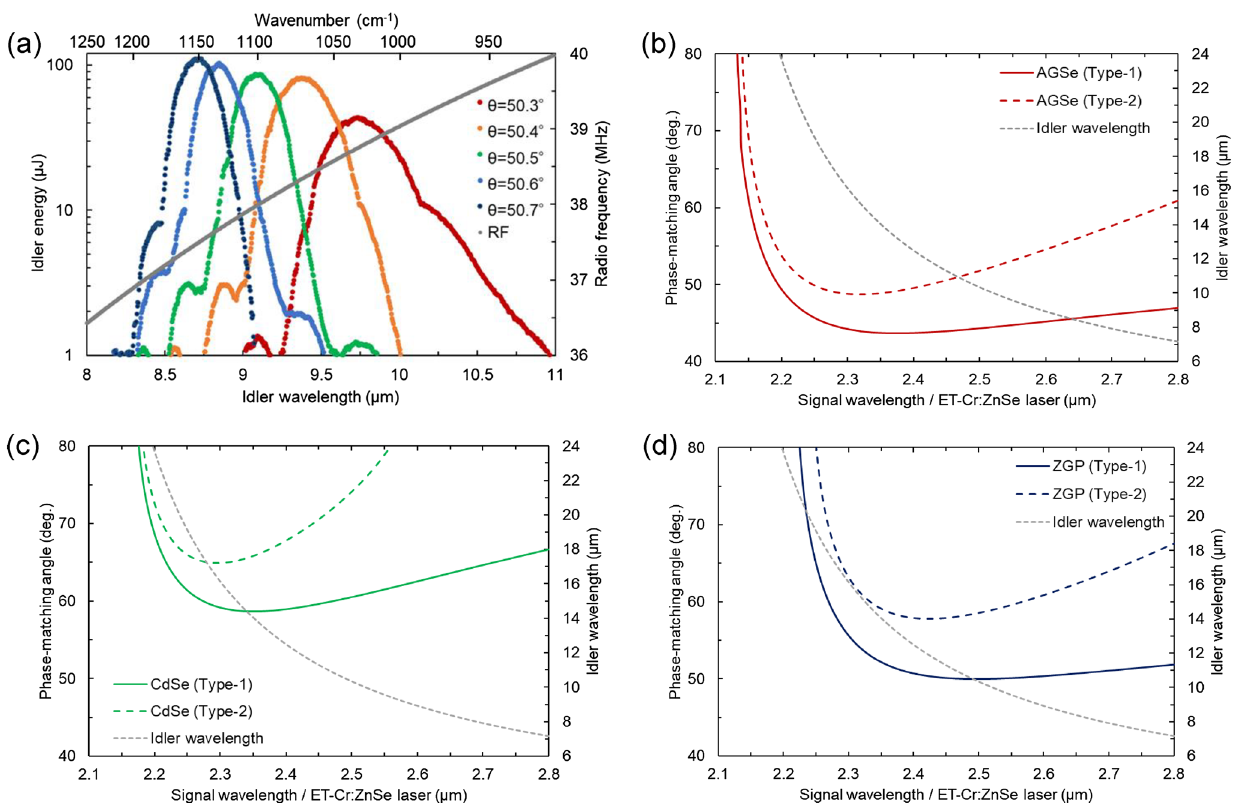
Figure 4. ( a ) Electronic tuning range of idler at PM angle of 50.3°, 50.4°, 50.5°, 50.6°, and 50.7°. Gray plots are RFs fed into the AOTF. ( b – d ) PM tuning curves for DFG in AGSe (type-1, 2), CdSe (type-1, 2), and ZGP (type-1, 2) at 20 °C. Pump and signal waves are given by the Tm:YAG laser (2.013 μm) and ET-Cr:ZnSe laser, respectively. The curve was calculated using Sellmeier’s equation of AGSe 29 , CdSe 30 , and ZGP 24